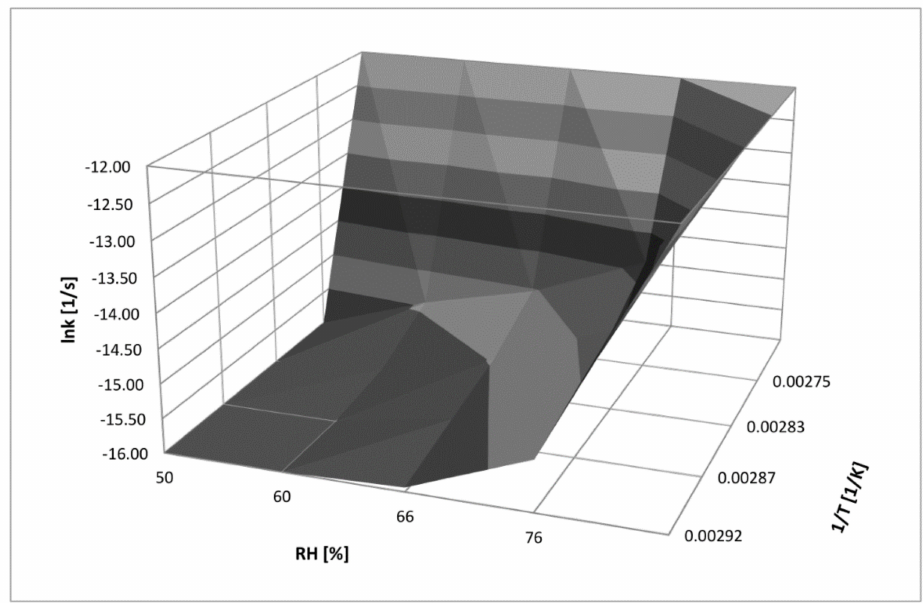
Figure 6. Three-dimensional relationship between temperature (1/T), RH, and k (lnk) for solid-state RAM degradation under humid